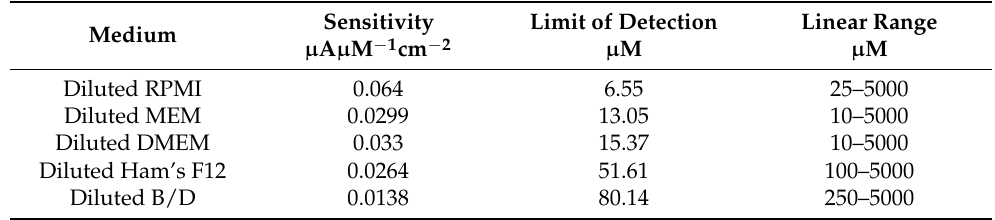
Table 1. Features of the AuNPs-rGO-based sensors using CH at − 800 mV vs. SCE as the electrochem- ical technique in different culture media diluted with